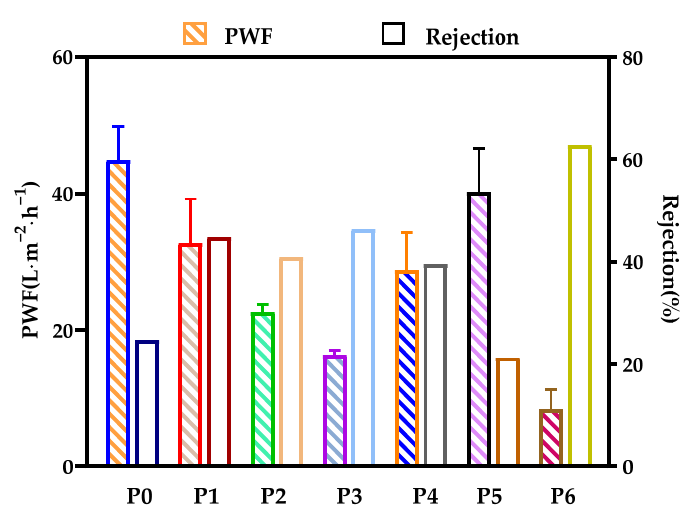
Figure 10. Pure water flux and BSA rejection of various PA66 membranes. As can be seen from the porosity diagram of the membrane, the overall trend of po- rosity remains at about 53.7%, but the P6 membrane has a lower porosity, which is because the increased viscosity of the casting solution makes the vacancies and pores in the mem- brane filled with crystal nuclei, making it more difficult for pores to form and grow. How- ever, P4P5 membranes have higher porosity, which is due to the dilution effect caused by a large amount of PC at the membrane–bath interface, which is consistent with the results obtained from SEM image observation and analysis [16]. Figure 11. Porosity of various PA66 membranes. 3.6. Anti-Fouling Performance of Developed Membranes The antifouling performance of various PA66 membranes was studied, and the flux recovery rate was taken as an important parameter to examine the water flux recovery of the membranes after protein permeation. According to Figure 12, the flux recovery rate (FRR) of the P0 membrane was only 21.1%. The reason is that the larger pores of the P0 membrane can easily accumulate foulants without the strong shear force between water and accumulating proteins when water permeates. Interestingly, the FRR values of the